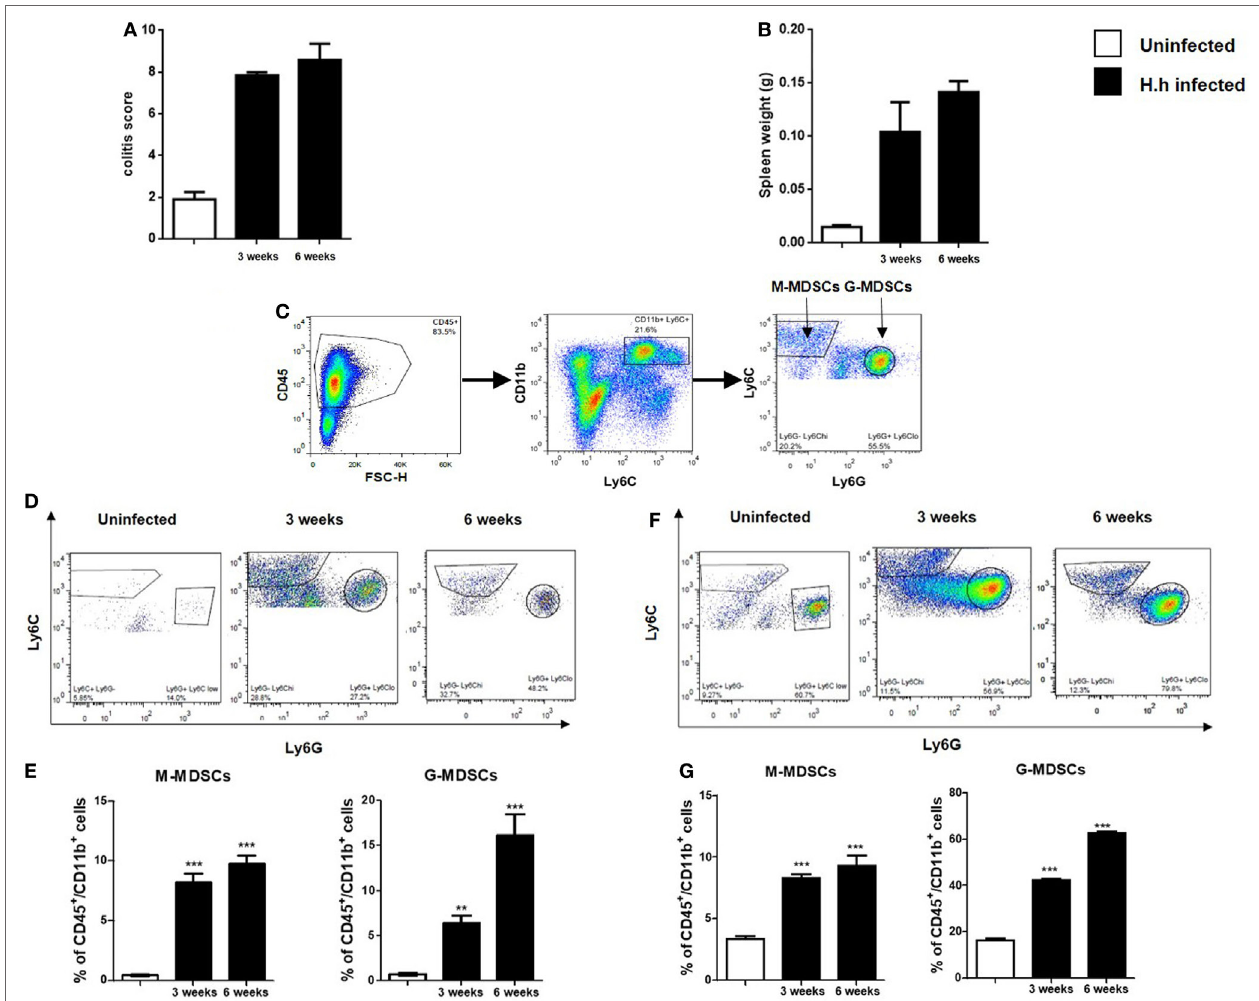
FigUre 1 | Helicobacter hepaticus ( Hh ) infection induces myeloid-derived suppressor cells (MDSCs) accumulation. 129SvEv Rag2 − / − mice were infected with Hh and sacrificed after 3 or 6 weeks after infection. (a) Scores of colon inflammation assessed by histological analysis. (B) Spleen weights. (c) Representative FACS plots showing the gating strategy used to identify MDSCs subpopulations. Following a leukocytes gate (CD45 + ), cells were further gated for CD11b + myeloid cells. Ly6C and Ly6G were used to distinguish M-MDSCs and G-MDSCs. (D–g) Flow cytometric analysis of M-MDSCs and G-MDSCs populations as gated in panel (c) and relative quantification in colon (D,e) and spleen (F,g) of 129SvEv Rag2 − / − uninfected or Hh -infected mice. The frequency of G-MDSCs and M-MDSCs significantly increased in time-dependent manner in both colon and spleen. In particular, 6 weeks post-infection, the accumulation of G-MDSCs was about 20- and 30-fold higher in colon and spleen, respectively, as compared to uninfected mice. On the other hand, intestinal or splenic M-MDSCs fraction only increased by 10% in Hh -infected mice 6 weeks post-infection. Data are shown as mean ± SEM ( n = 5 per group) (** P < 0.01, *** P < 0.001 vs.